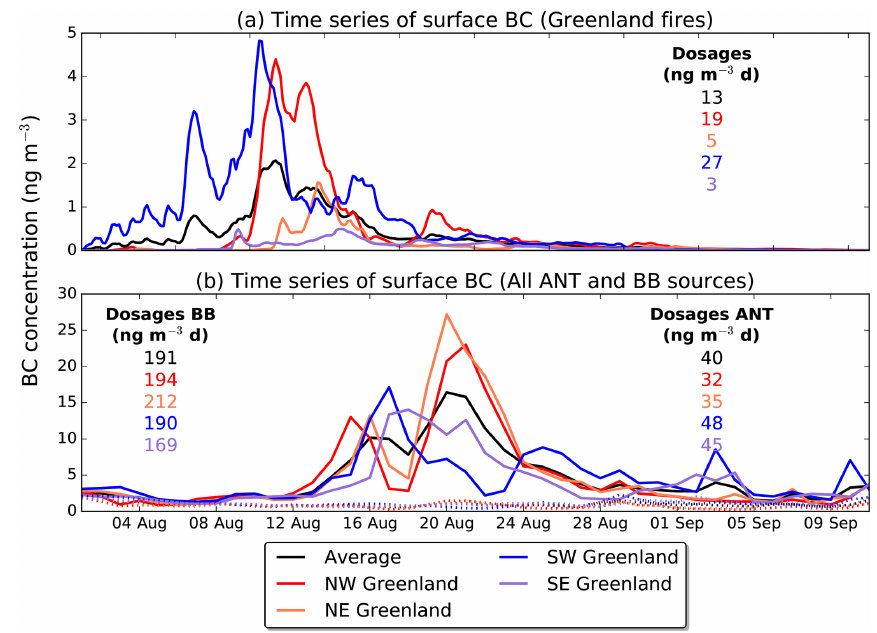
Figure 4. (a) Time series of surface BC concentrations in northwestern, northeastern, southwestern and southeastern Greenland from the summer 2017 fires in western Greenland. (b) Time series of surface BC concentrations in northwestern, northeastern, southwestern and southeastern Greenland from global anthropogenic (ANT; dashed lines) and biomass burning (BB; solid lines) emissions for the same period. The numbers represent the respective dosages (time-integrated concentrations) for the time period shown. The color codes are reported in the